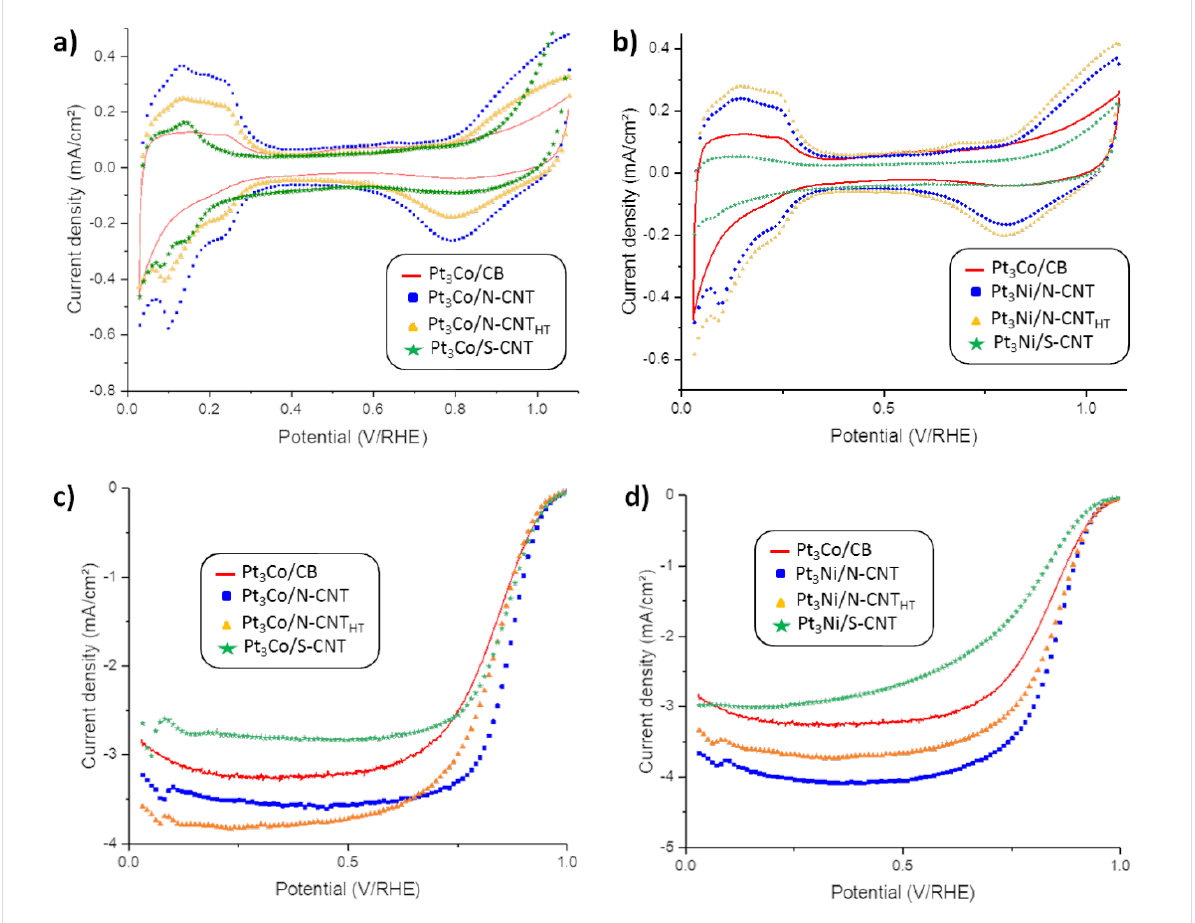
Figure 4: CVs from an RRDE experiment for the catalysts in 0.5 M H 2 SO 4 at 5 mV·s − 1 under N 2 at 25 °C for a) the Pt 3 Co/CB and Pt 3 Co/CNT series and b) the Pt 3 Co/CB and Pt 3 Ni/CNT series. Background of linear sweep voltammetry (LSV) with RRDE experiment for the catalysts in 0.5 M H 2 SO 4 at 5 mV·s − 1 at 900 rpm under O 2 at 25 °C for the c) Pt 3 Co/CNT and d) Pt 3 Ni/CNT series.